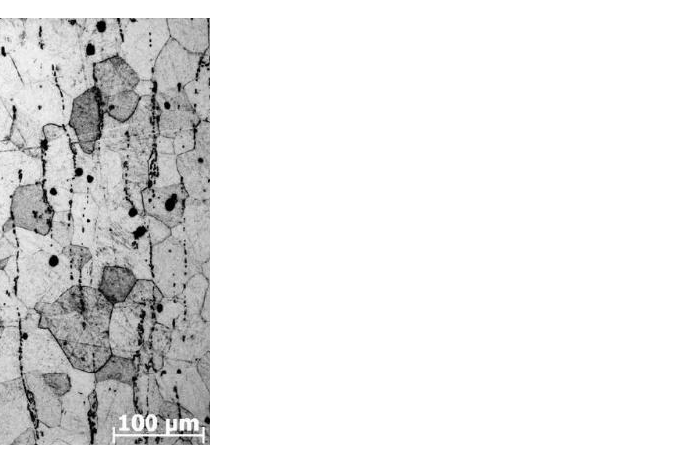
Figure 1. The optical microscopy image of microstructure in Ti 49.4 Ni 50.6 (at%) samples in rolling plane.